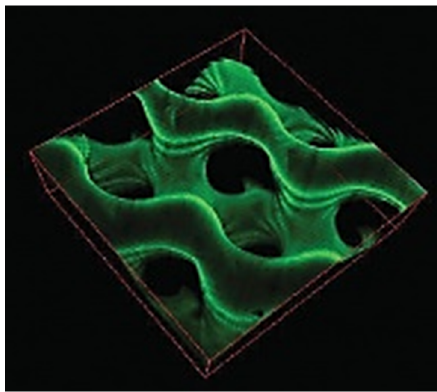
Figure 2. Carboxybetaine methacrylamide (CBMAA)-based porous hydrogel having a gyroid structure. The structure is visualized using a confocal microscope where FITC-BSA is adsorbed on the surface. Adapted with permission from Kostina et al . [79].